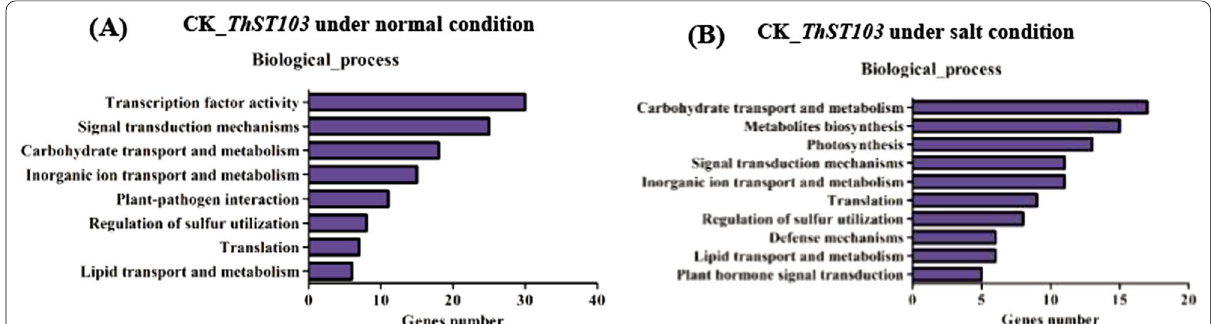
Fig. 6 The GO grouped up-regulated genes in one main category: biological processes. A The number of genes involved in biological processes under normal conditions. B The number of genes involved in biological processes under salt conditions